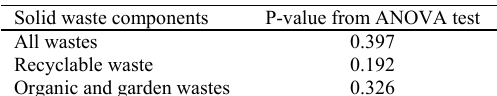
010203040506070 Fig. 4: According to season percentage of paper, glass, plastic and Fig. 4: According to season percentage of paper, glass, plastic and metal wastes metal Fig. 3: According to season percentage of organic and garden wastes Fig. 3: According to season percentage of organic and garden wastes